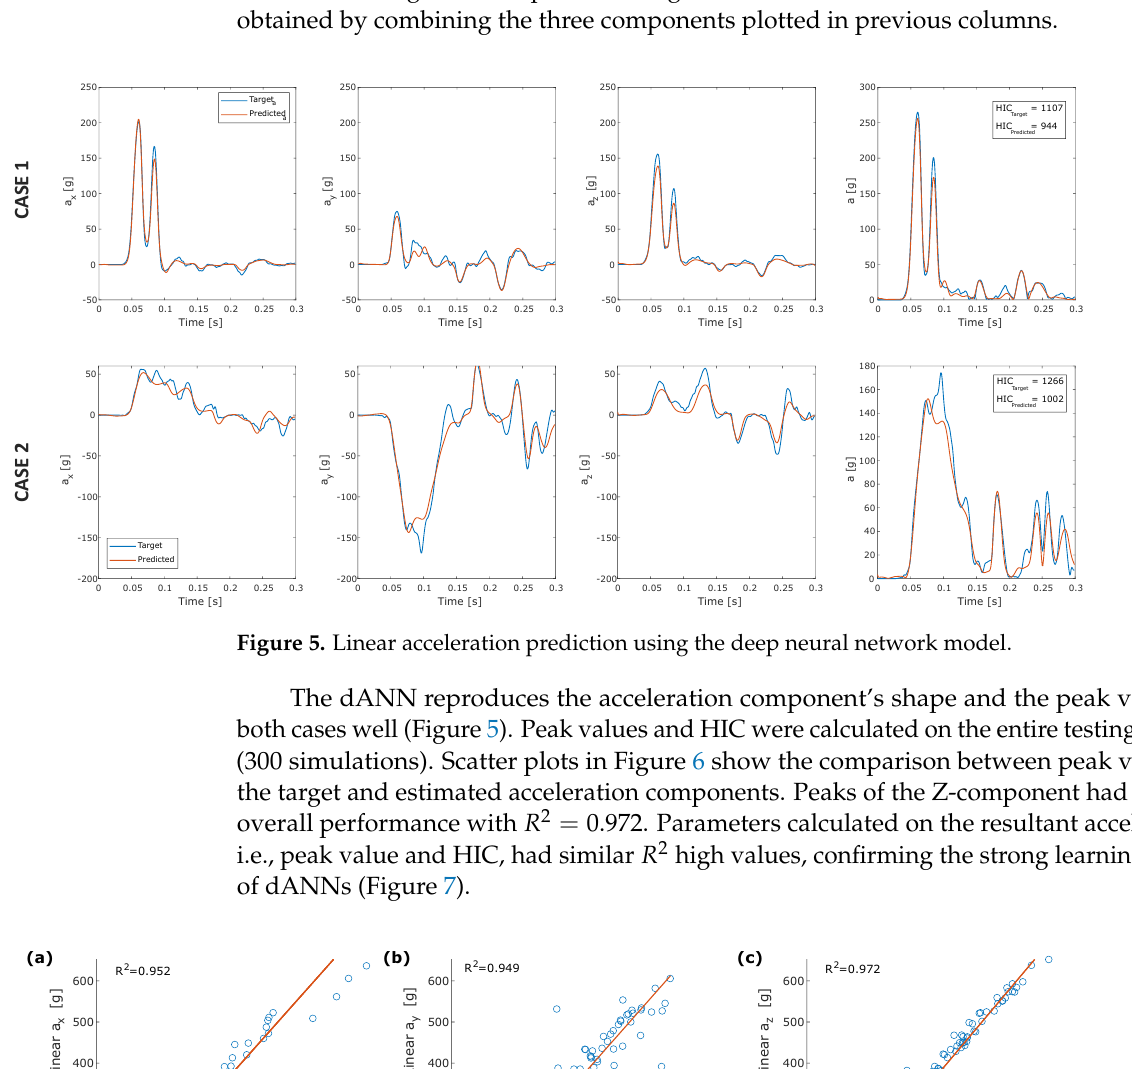
and the first fully-connected layer had 200 hidden units. Dropout probability was set equal to 0.5 and learning rate equal to 0.001. Two examples of the estimated linear acceleration are shown in Figure 5: the plot in the rightmost column shows the resultant accelerations obtained by combining the three components plotted in previous columns.